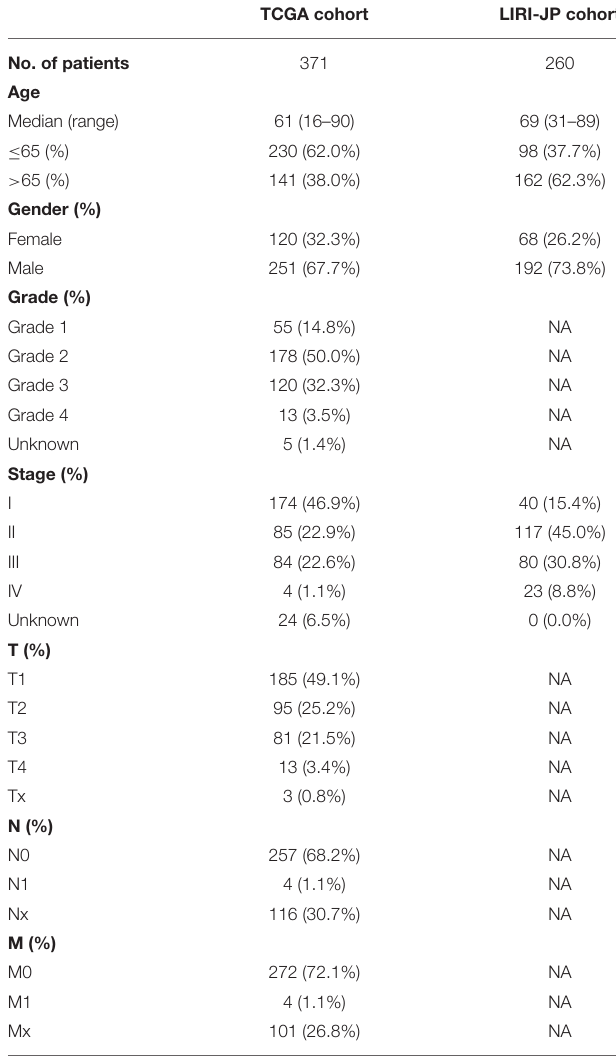
TABLE 1 | Clinical characteristics of the HCC patients used in this